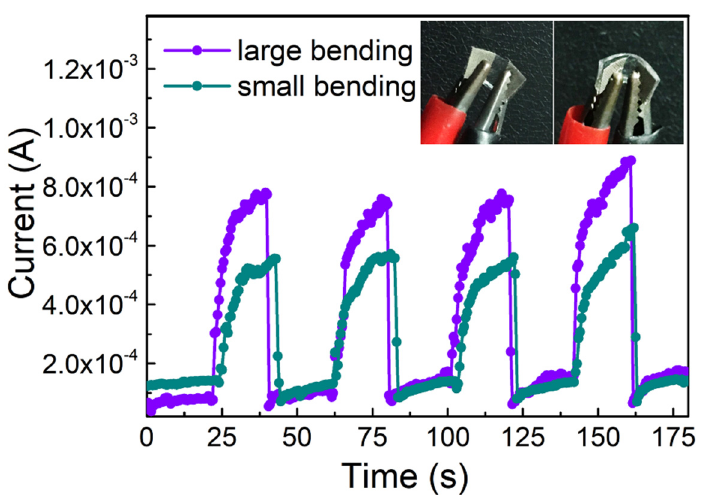
Figure 3. ( a , b ) Optical images of the straight and bending microwire under insulating substrate to test I-V characteristics. ( c ) I-V characteristics of the straight microwire and the bending microwire. ( d ) I-V characteristics of bending microwire under different applied voltage.